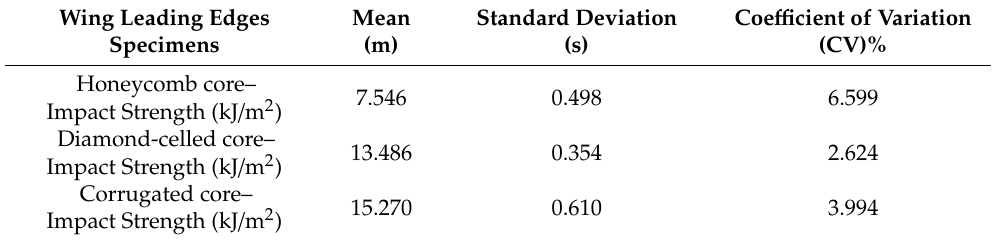
Table 8. Statistical parameters determined from the impact test of wing leading edges specimen.